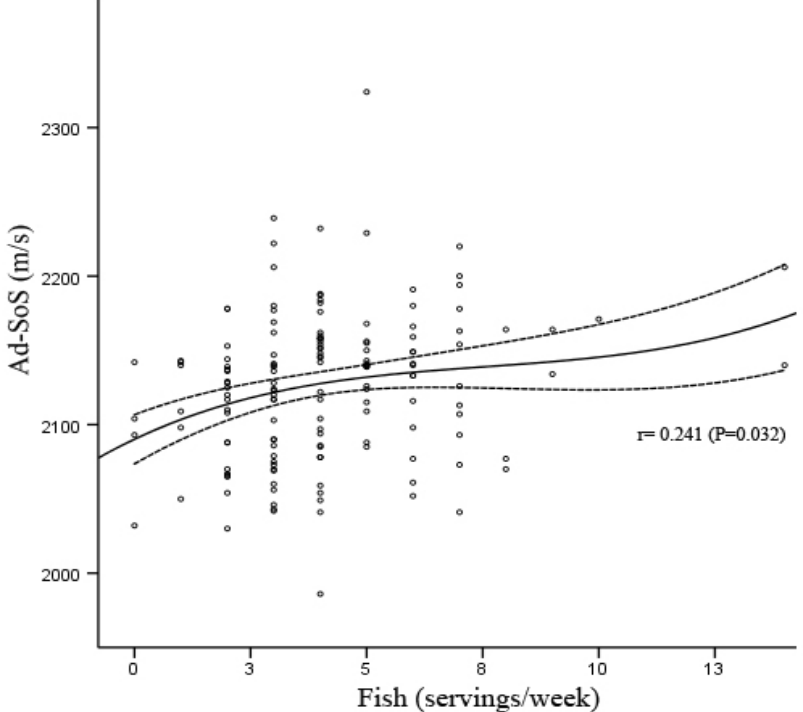
Figure 1. Best fit relationship between Ad-SoS (m/s) and fish consumption (servings/week) using cubic regression model with 95% confidence